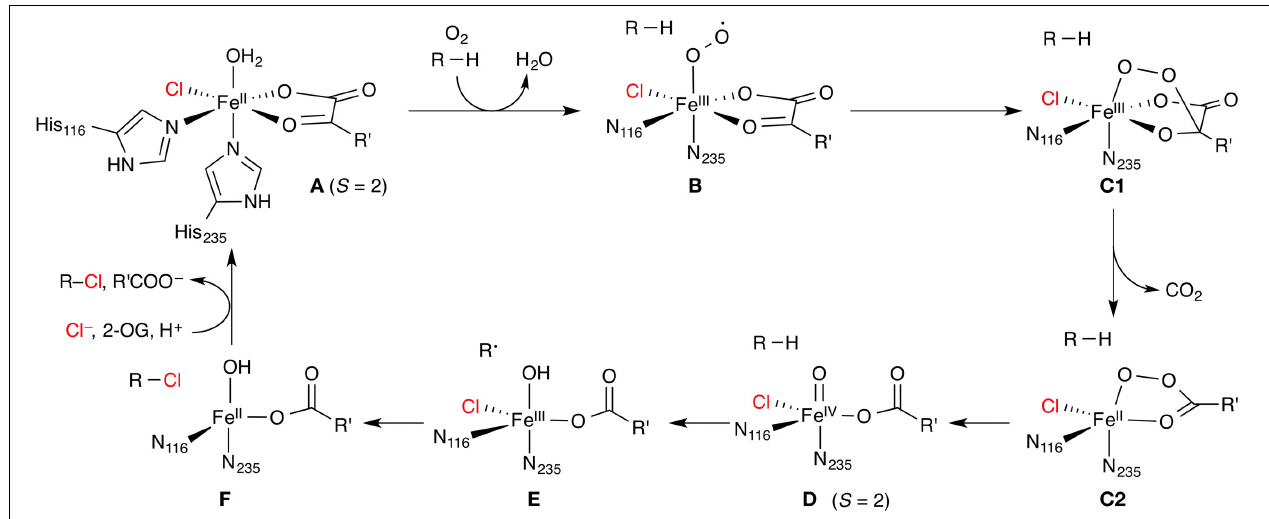
FIGURE 5 | Proposed catalytic cycle of non-haem iron/2-oxoglutarate (2-OG) dependent halogenases. R is an aliphatic carbon center of the substrate; R (cid:2) = (CH 2 ) 2 COO − . The numbering of His residues is taken from SyrB2.